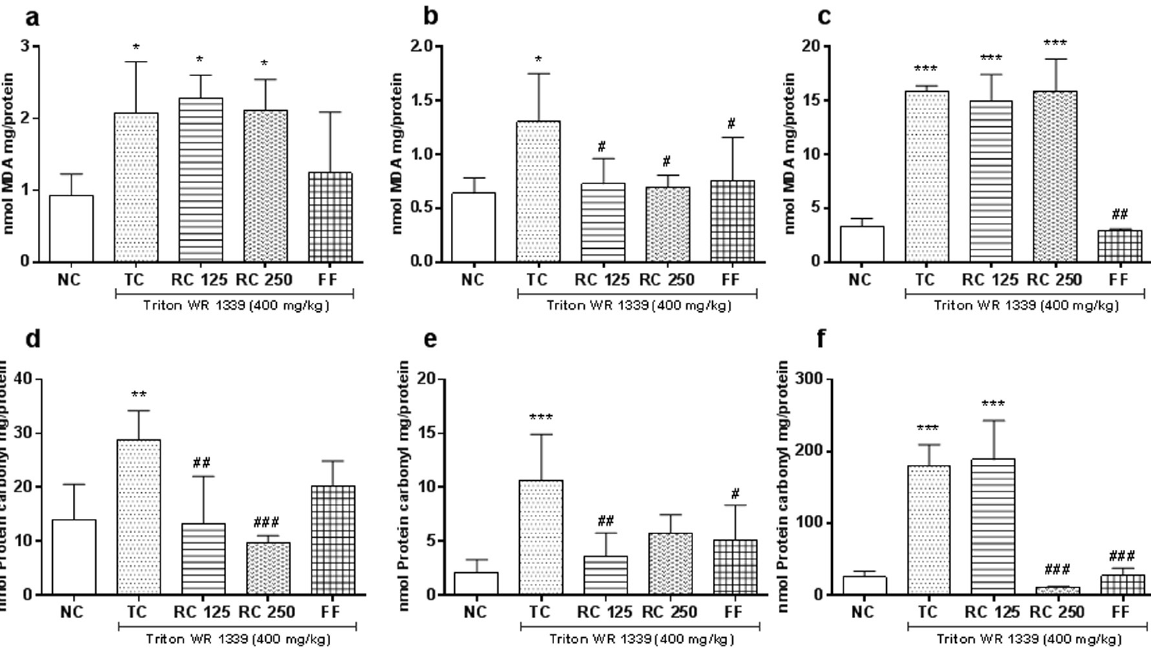
Figure 1. Effects of red cabbage aqueous extract (RC) and fenofibrate (FF) treatments on oxidative stress markers in kidneys (left, panels a and d), liver (middle, panels b and e) and serum (right, panels c and f) of Triton WR- 1339-induced hyperlipidemia in rats. Bars represent means± S.D. (n=5–6). * p <0.05, ** p <0.001, *** p <0.001 vs normal control (NC) and # p <0.05, ## p <0.01, ### p <0.001 vs Triton control (TC), according to one-way ANOVA followed by the Tukey’s post hoc test. MDA=